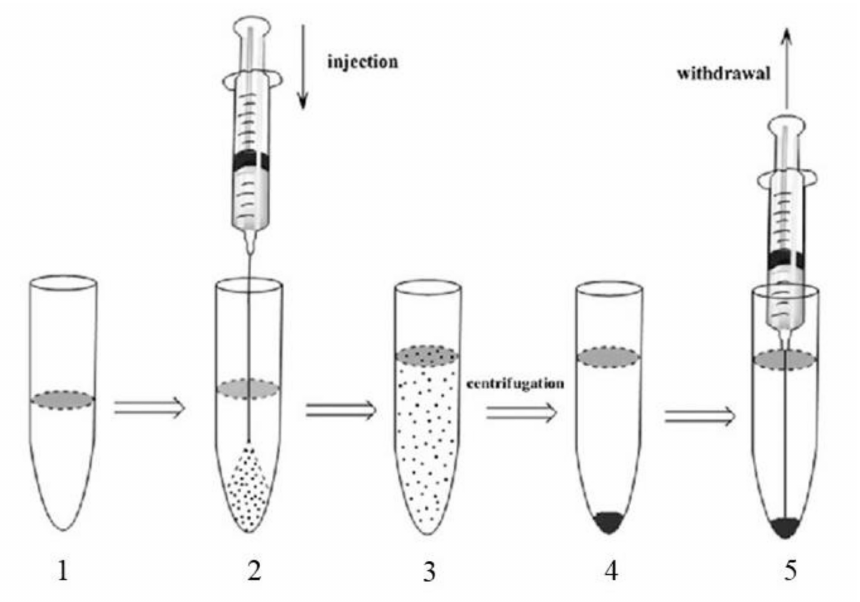
Figure 9. DLLME procedure: (1) sample with analytes; (2) dispersive solvent injection; (3) dispersion; (4) sedimentation; (5) removal of the